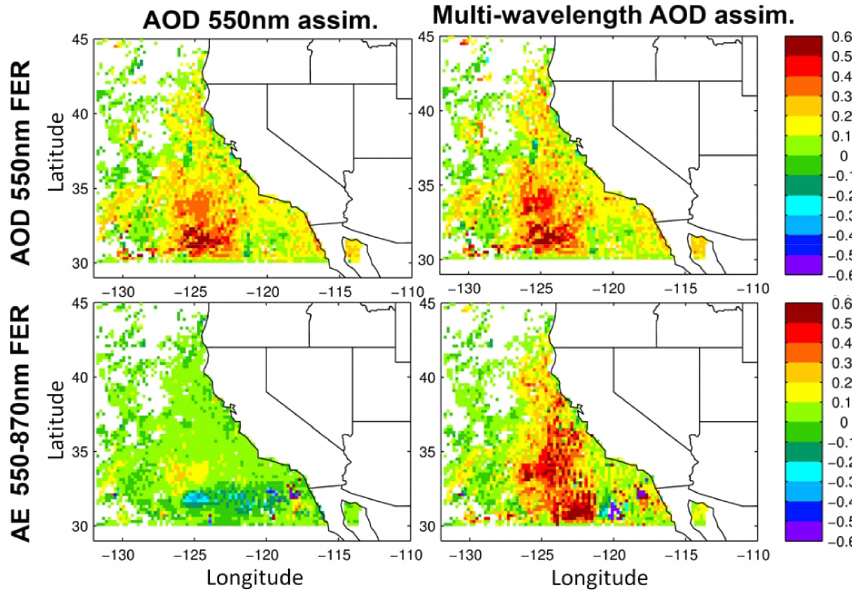
Figure 7. Fractional error reductions for 550nm AOD and 550–870nm Ångström exponents (rows) from non-assimilated to assimilation of Terra retrievals computed using Aqua retrievals (e.g., errors for a ∼ 3h forecast). Figures in the left column assimilate only MODIS 550nm AOD, while the ones in the right column assimilate MODIS 550, 660, 870, and 1240nm over the ocean and only 550nm over land. Modified from Saide et al.